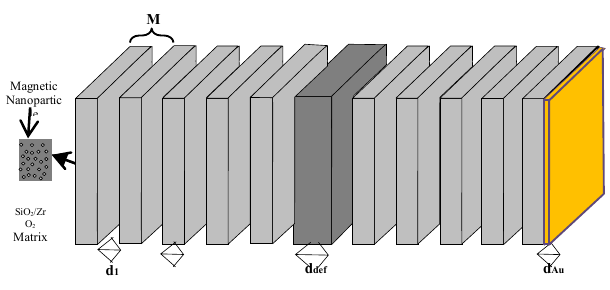
FIGURE 1. Schematic of 1D photonics crystal structure made with magneto- optic layers with one defect.